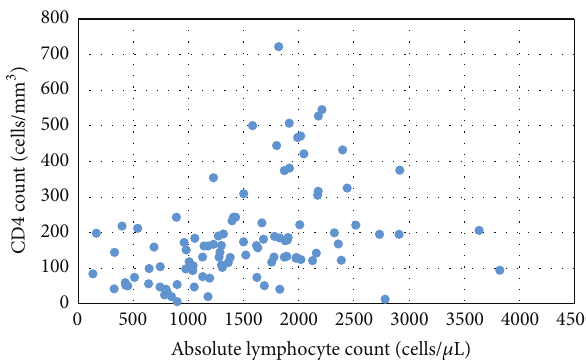
Figure 1: Distribution of absolute lymphocyte count and CD4 cell count in HIV-infected individuals before initiation of antiretroviral